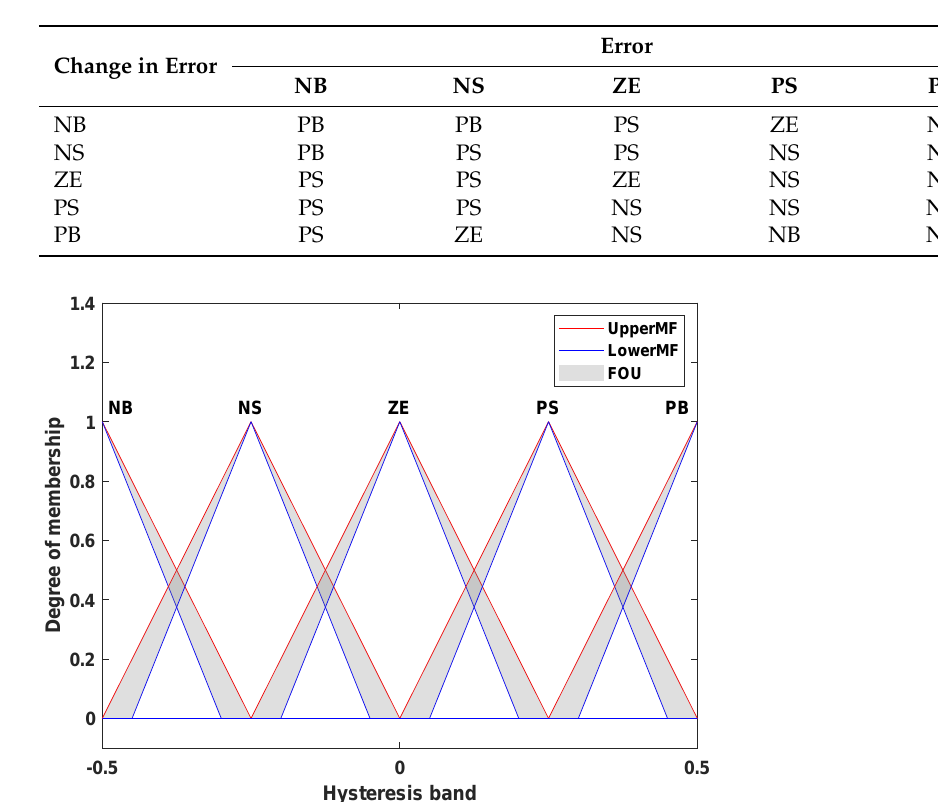
Table 1. Rules of IT2FS.